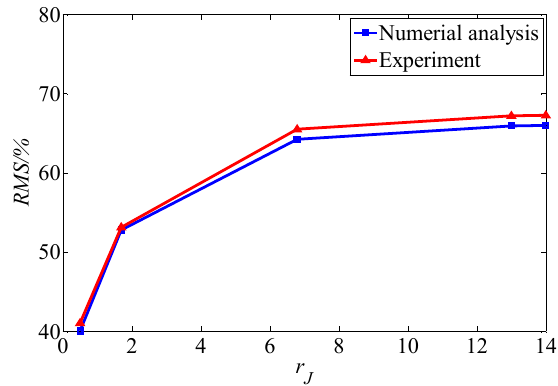
Figure 15. Comparison of experimental and numerical analysis results.